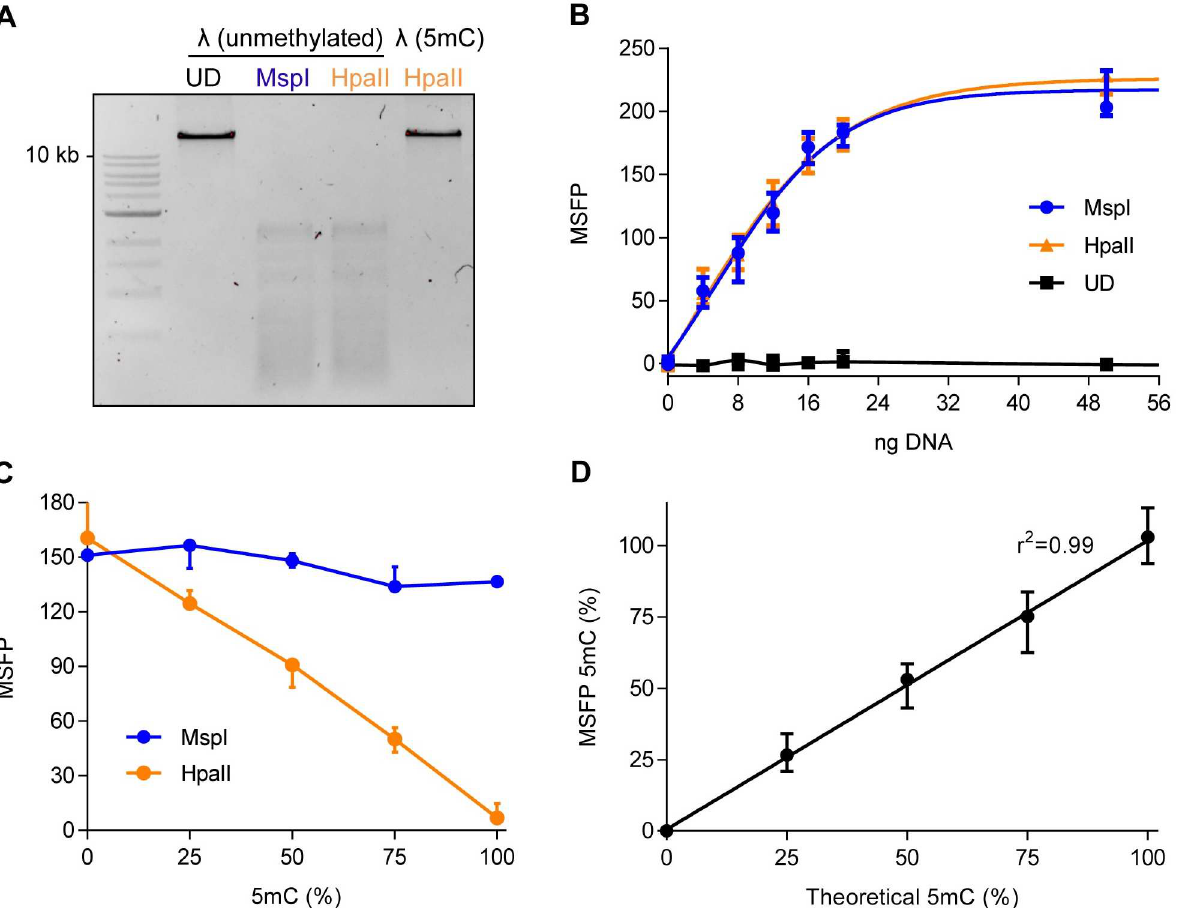
Fig 2. Measurement of global DNA methylation using the MSFP assay. (A) In-vitro methylation of λ DNA was confirmed by HpaII digestion. Unmethylated and fully-methylated (5mC) λ DNA were digested by either MspI or HpaII and the digestionpattern was visualizedby agarose gel electrophoresis. UD: undigested. (B) The standard curves represent unmethylated λ DNA, showingmedians and ranges of 3–7 independent experiments, each performed in technical duplicatesor triplicates. The amounts of digested DNA applied per well are indicatedon the x-axis. (C) The MSFP measurement of λ DNA with different DNA methylation levels. Unmethylated and 5mC λ DNA were mixed to obtain 10 ng of DNA with various DNA methylation levels (0, 25, 50, 75, 100%) followedby the MSFP assay. The data show medians and ranges of three independent experiments, each performed in technical triplicates. (D) The accuracy of the DNA methylation level (%) determined by the MSFP. The DNA methylation content (5mC) of each analyte from Fig 2C was calculated accordingto the formula in the Materials and Methods section. The data represent medians and ranges of three independent experiments,each performed in technical triplicates.